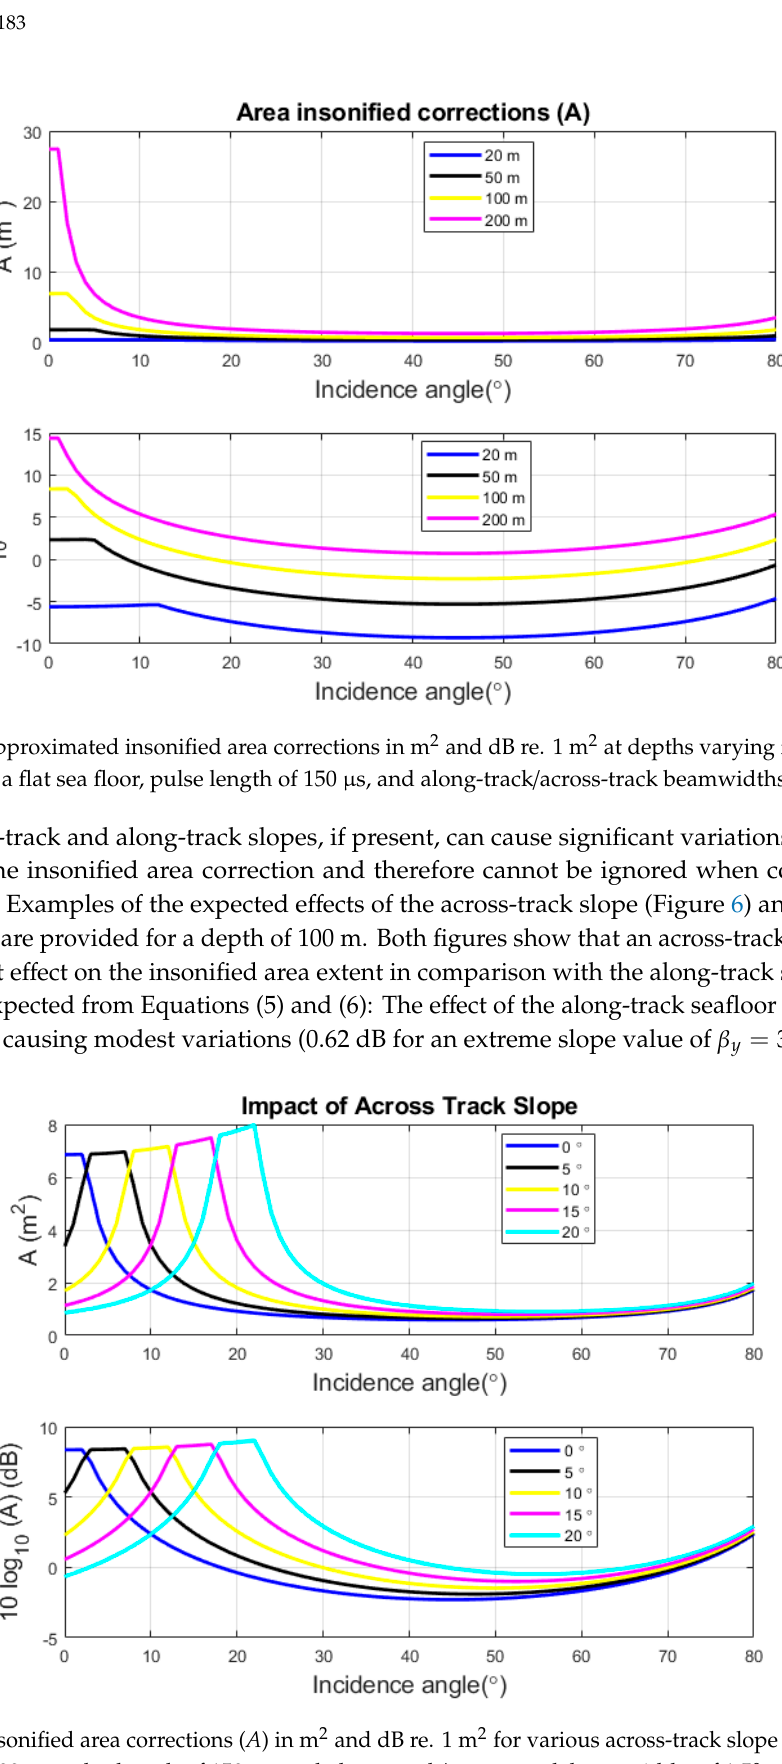
Figure 7. Insonified area corrections ( A ) in m (cid:2870) and dB re. 1 m² for various along-track slope values for a depth of 100 m, pulse length of 150 μs , and along-track/across-track beamwidths of 1.5°.